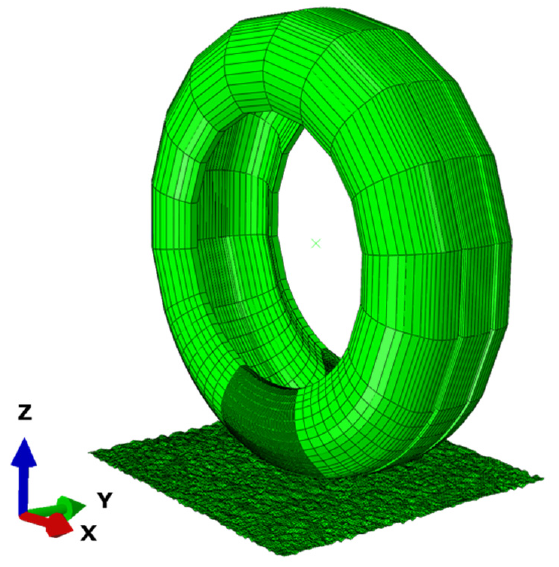
Figure 2. Tire–pavement assembly.